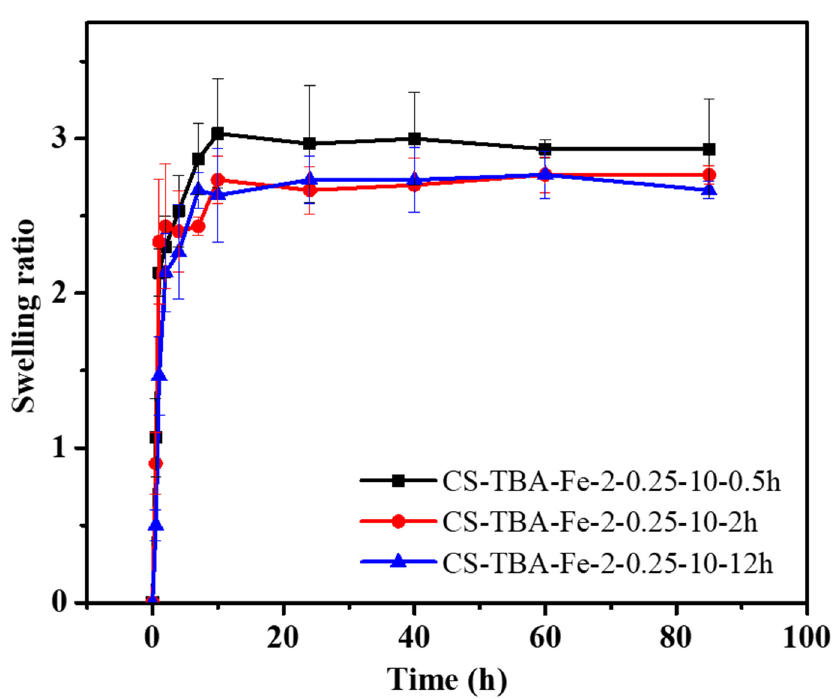
Figure 4. Swelling test of CS-TBA-Fe hydrogels with different curing time.